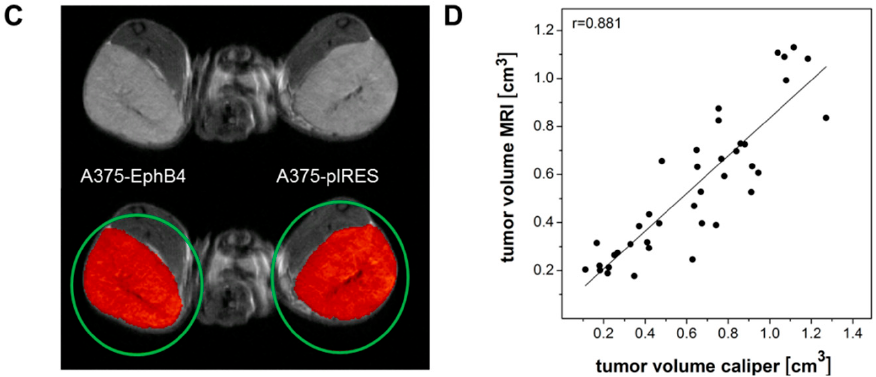
Figure 2. Overexpression of EphB4 in A375 melanoma cells increases cell proliferation and growth of corresponding tumor xenografts. ( A ) Cells were cultivated in 6-well plates and number of viable cells was determined after trypsinization using a CASY ® Model TT cell counter. Values represent mean ± SEM from one of at least three independent experiments, each performed in quadruplicate (* p < 0.05). ( B ) Tumor size was monitored thrice a week by caliper measurement and tumor volume was calculated using the formula V = π /6 (tumor length tumor width 2 ). Values represent mean ± SEM from three independent experiments with a total of 49 mice (* p < 0.05). ( C ) In addition to caliper measurement, tumor volume was determined in a subset of mice by MRI. Using the ROVER software,